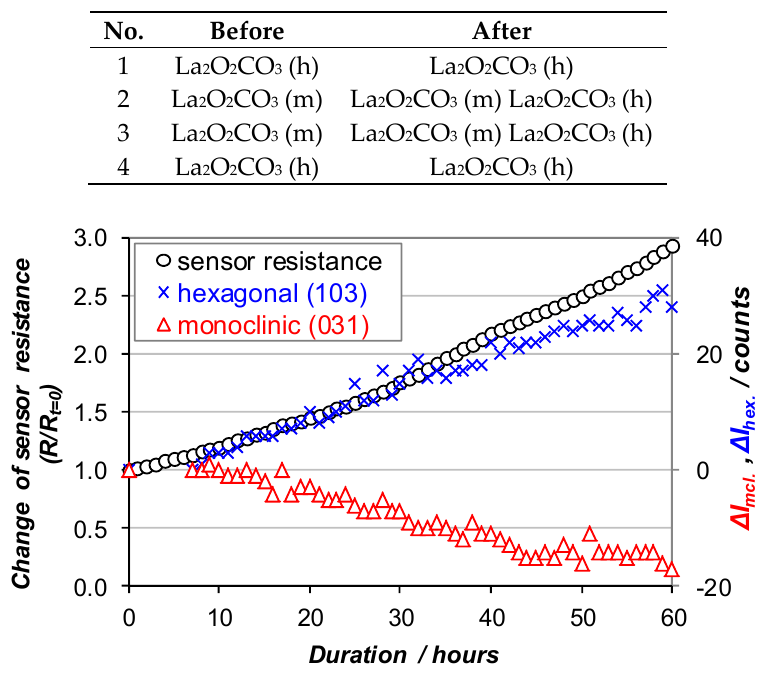
Table 2. Results of XRD before and after the aging process. (h = hexagonal, m = monoclinic).